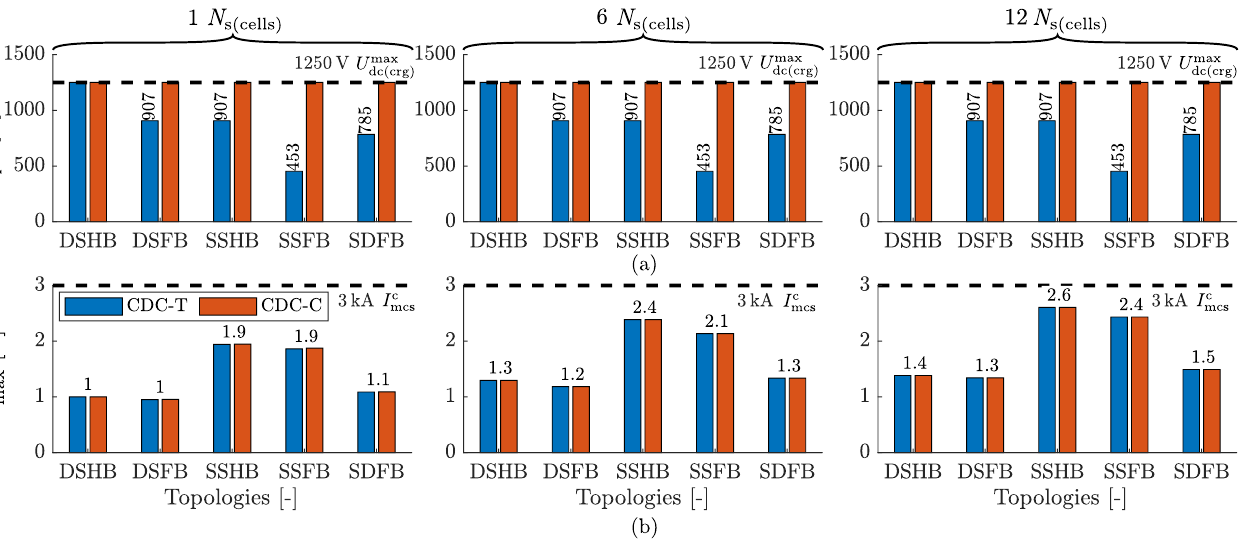
Figure 7. The maximum BI-MMC DC link voltage and maximum DC charger current considering the two different DC charging scenarios: CDC-T and CDC-C for all topologies with 1, 6, and 12 N s(cells) with the maximum allowable DC voltage and current for MCS [34]. ( a ) maximum BI-MMC DC link voltage ( U pn ) and the maximum MCS DC charger voltage ( U max ), and ( b ) maximum DC charger dc(c) current ( I c max ) the maximum MCS DC charger current ( I c mcs ).